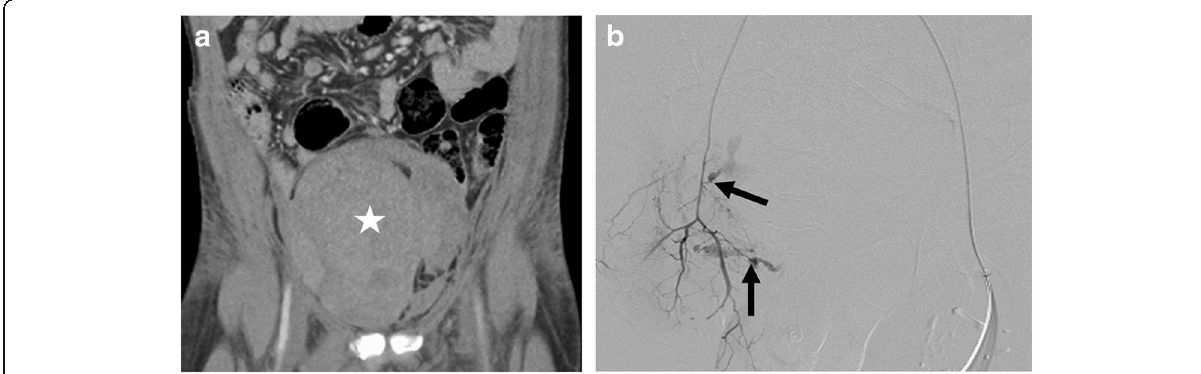
Fig. 1 a . Coronal reconstruction of a negative CTA. A large extraperitoneal hematoma (star) is seen in the pelvis. No active extravasation of contrast or abnormal vessel was seen on CTA. b . Posterior-anterior projection digital subtraction angiogram of the obturator branch of the anterior division of the right internal iliac artery. This was performed using an end-hole catheter inserted from a left common femoral artery access sheath. Active hemorrhage is seen from two branch arteries (black